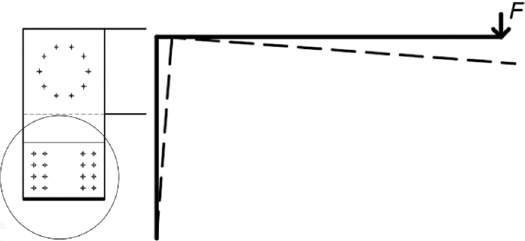
Figure 5. Semirigid connection between the stand and the steel plate (on the left); deformation due to inclination (on the right).